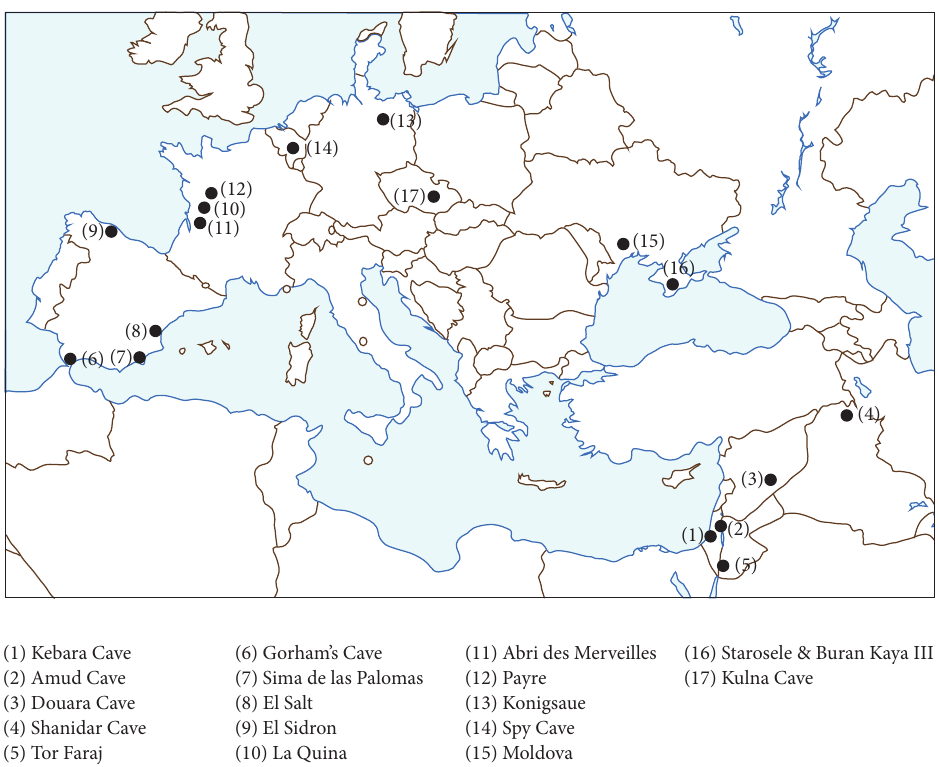
Figure 1: Locations of archaeological sites associated with evidence for plant use by